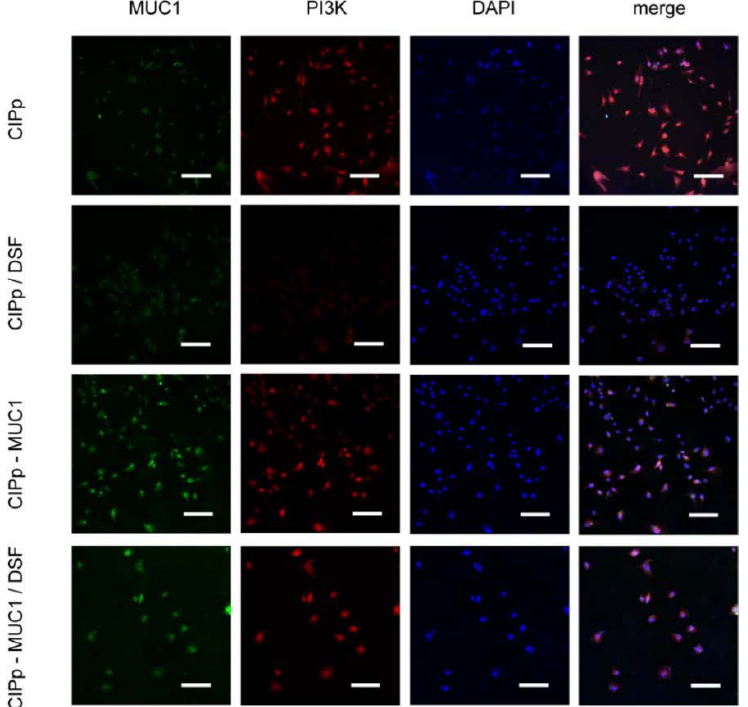
Figure 2. Overexpression of MUC1 attenuated the inhibitory effect of disulfiram on PI3K expression. The expression level of PI3K and MUC1 in CIPp and CIPp-MUC1 cells treated with or without 100 nM disulfiram for 48 h were detected by immunofluorescent imaging under confocal microscopy (×20). Nucleuses were stained with DAPI (Blue color, Excitation wavelength: 340 nm), PI3K proteins were stained with RFP conjugated antibody (Red color, Excitation wavelength: 550 nm), and MUC1 proteins were stained with fluorescein isothiocyanate (FITC) conjugated antibody (Green, Excitation wavelength: 488 nm). Bar = 150 μ m. Data were representative of three independent experiments.